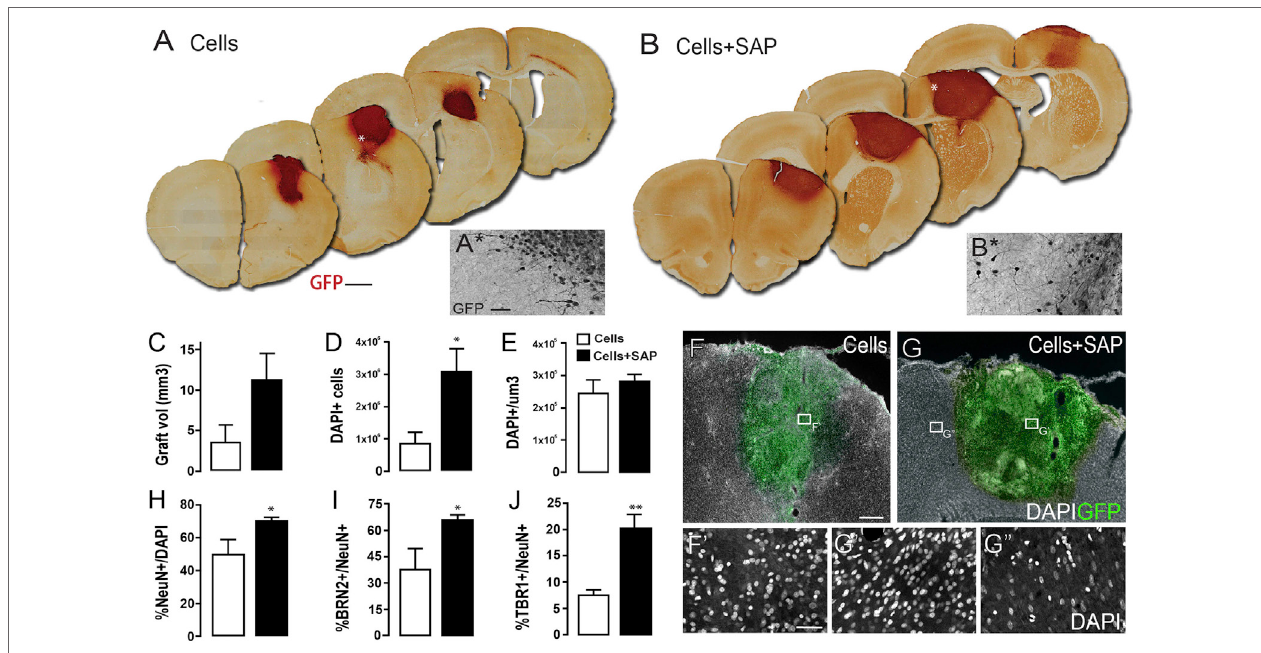
FiGURe 4 | Human neural progenitor cells (hNPCs) encapsulated in a self-assembling peptide (SAP) hydrogel and delivered into a stroke-injured rat brain demonstrate increased cell survival and differentiation into neurons. Representative coronal brain sections containing (A) cells or (B) cells + SAP. (C) Graft volume. (D) Number and (e) density of hNPCs detected in each group. (F–G) Representative images of (F) transplanted cells alone or (G) in combination with SAP hydrogel. (H–J) Percentage of hNPCs expressing neuronal markers. Reproduced with permission from Somaa et al.